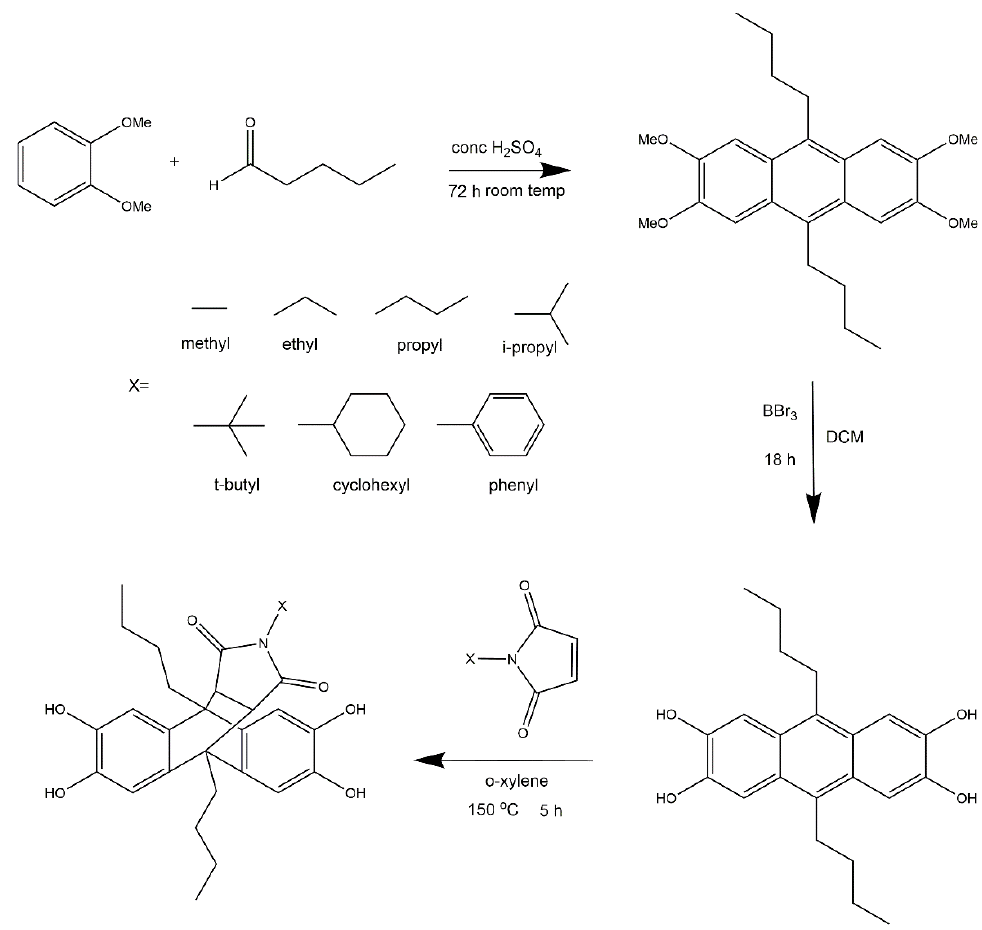
Figure 1. Synthesis route of the new comonomers.